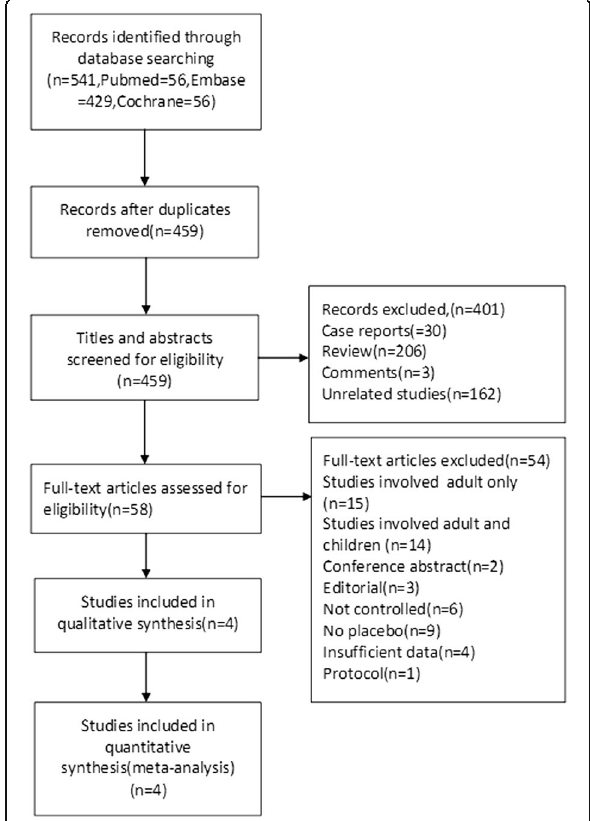
Fig. 1 Flow diagram of the study selection